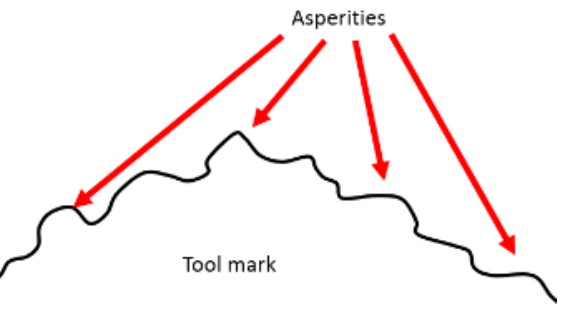
Figure 14. The asperities on the tool mark surface were removed first, followed by the tool mark itself.